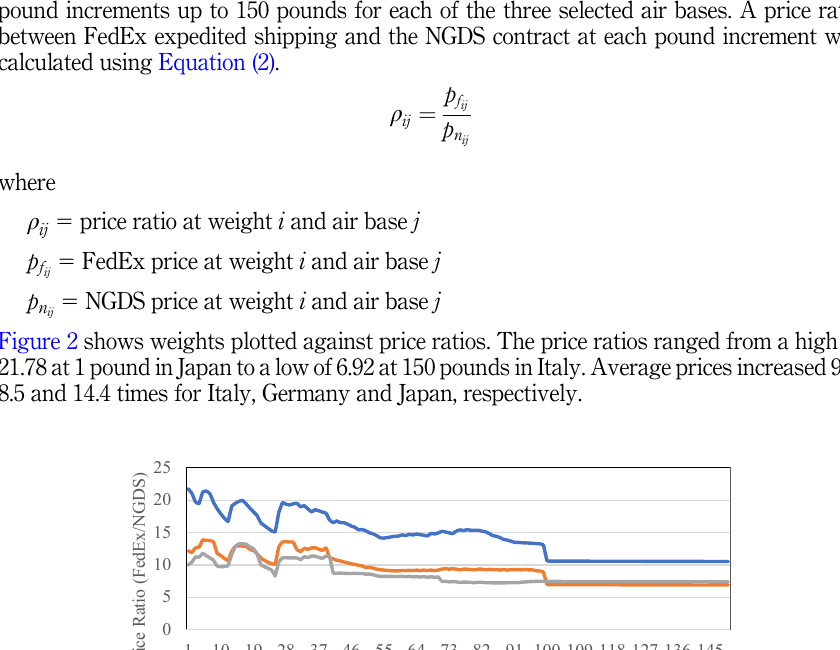
Figure 2. Price ratio for FedEx vs. NGDS at given